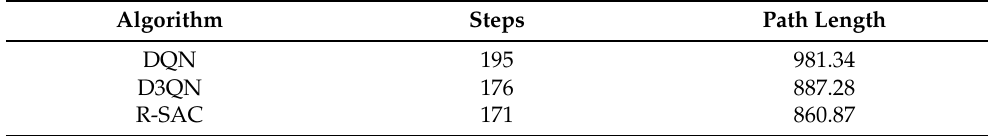
Figure 9. The reward curves of DQN, D3QN, R-SAC algorithm with target point of (500, 500). Table 4. The steps and path length of DQN, D3QN, R-SAC algorithm with target point of (500,